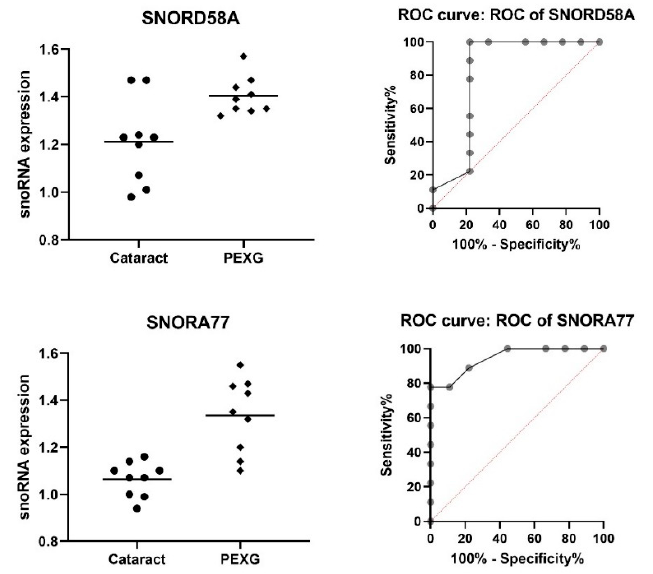
Figure 2. Higher snoRNA expression in the PEXG group compared to the cataract group. Data are shown as mean [log2].